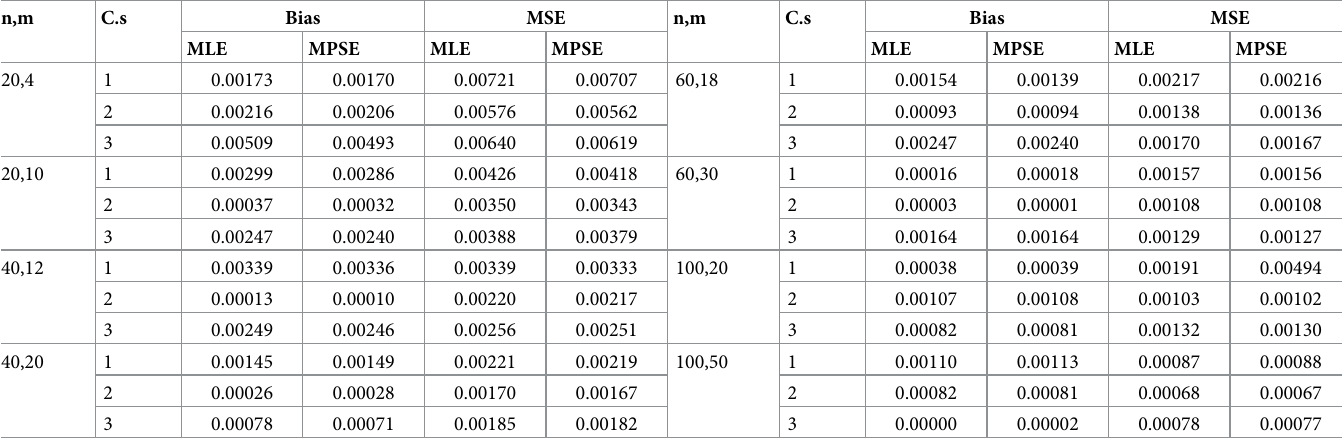
Table 7. Bias and MSE of θ with T